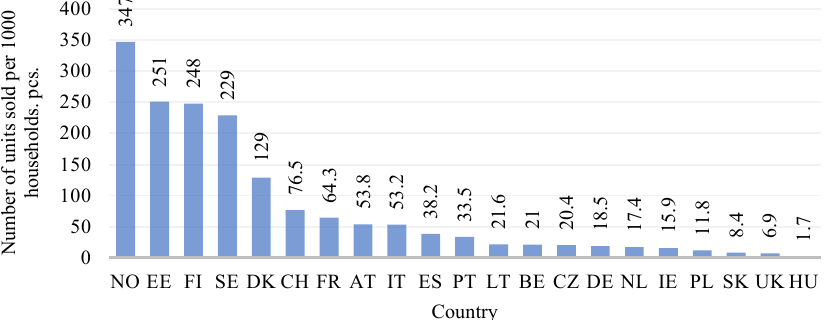
Fig. 2. The number of heat pumps sold per 1000 households.